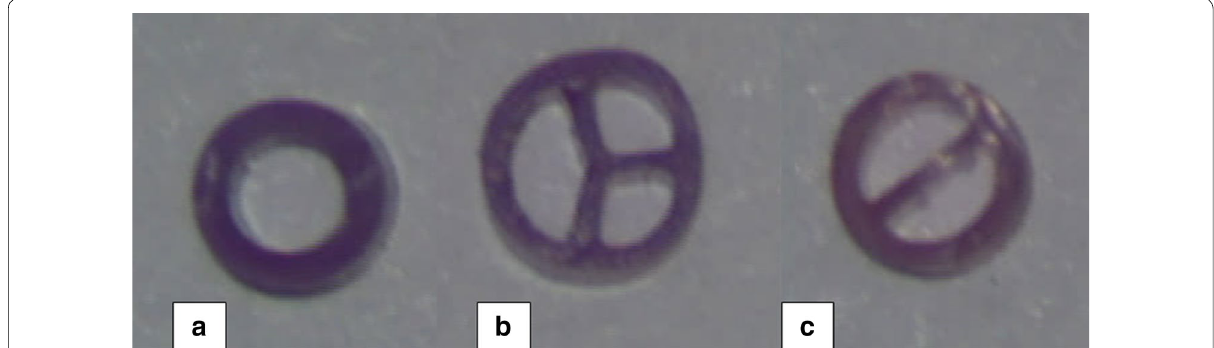
Fig. 3 Cross section of catheters. A Single-lumen 5fr; B Triple-lumen 6Fr; C Double-lumen